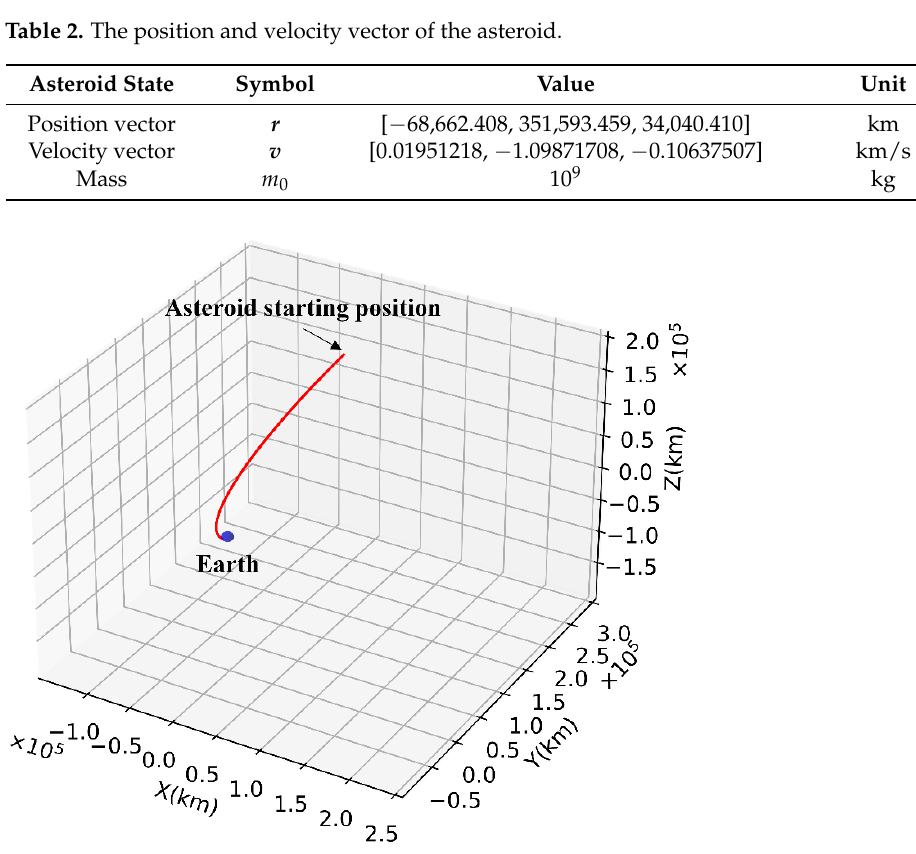
Figure 5. The initial flight trajectory of the asteroid.